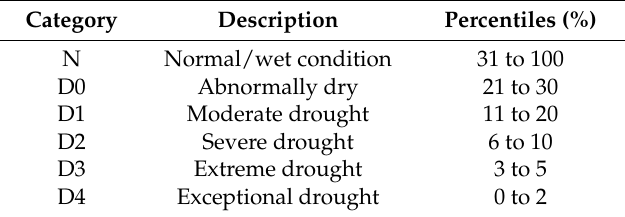
Table 2. United States Drought Monitor (USDM) drought categories employed in this study to categorize drought intensity.